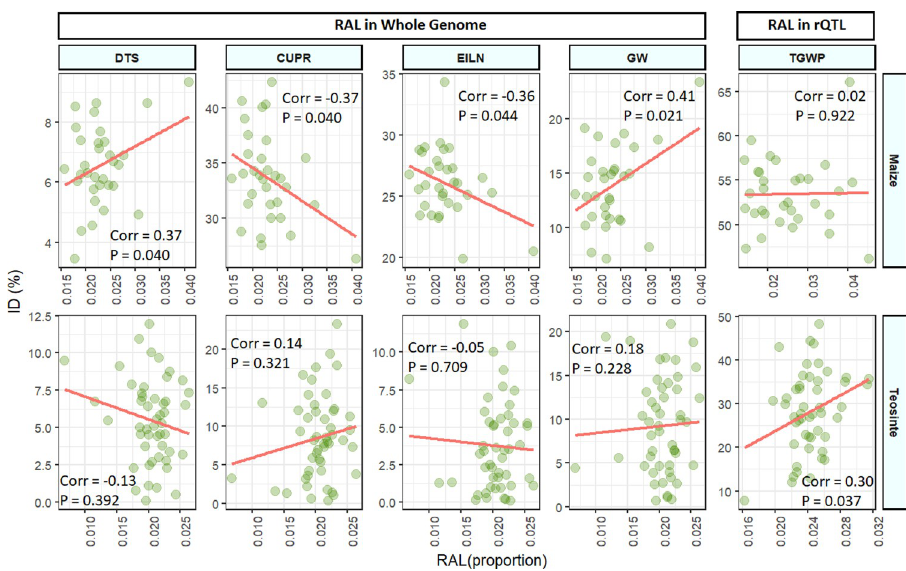
Fig 8. Percent inbreeding depression of individual families related to the parental rare allele load (RAL) measured genome-wide and within QTL CI for affected traits in maize and teosinte. Only traits for which a significant (P < 0.05) correlation was observed within one of the populations are